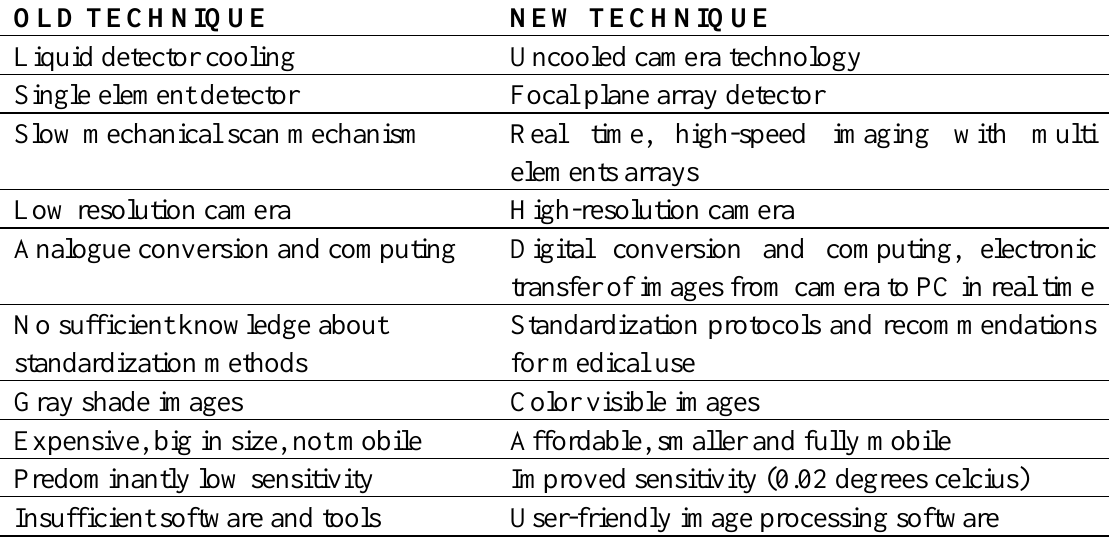
Table 1. Development of infrared sensor